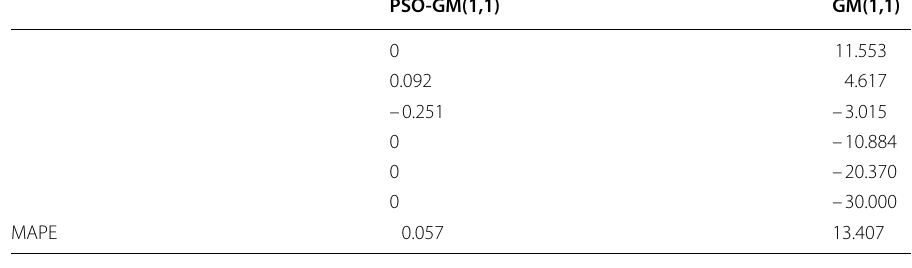
Table 2 Percentage prediction errors for PSO-GM(1,1) and GM(1,1) for a monotonic decreasing data